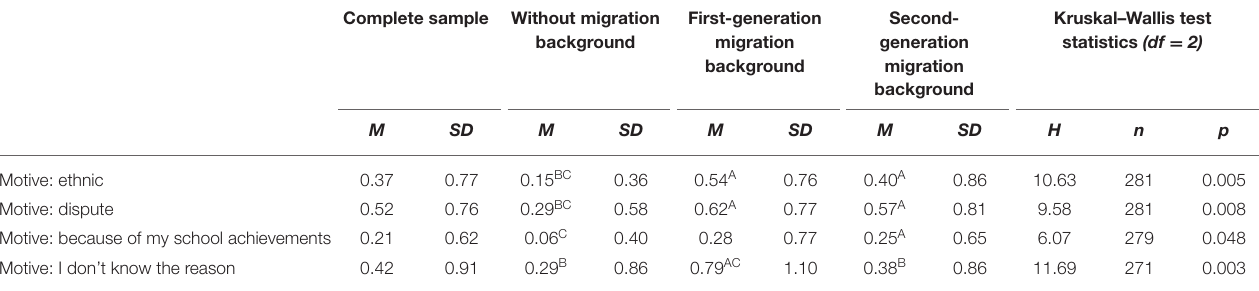
TABLE 2 | Kruskal–Wallis-Tests concerning the motives for cybervictimization.